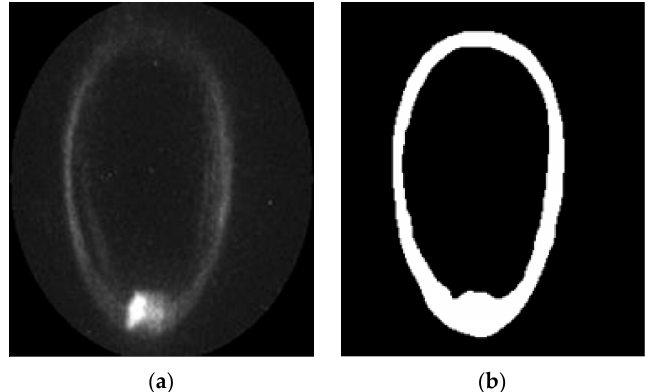
Figure 8. Auroral oval image and the corresponding benchmark image. ( a ) Auroral oval image. ( b ) Benchmark image.